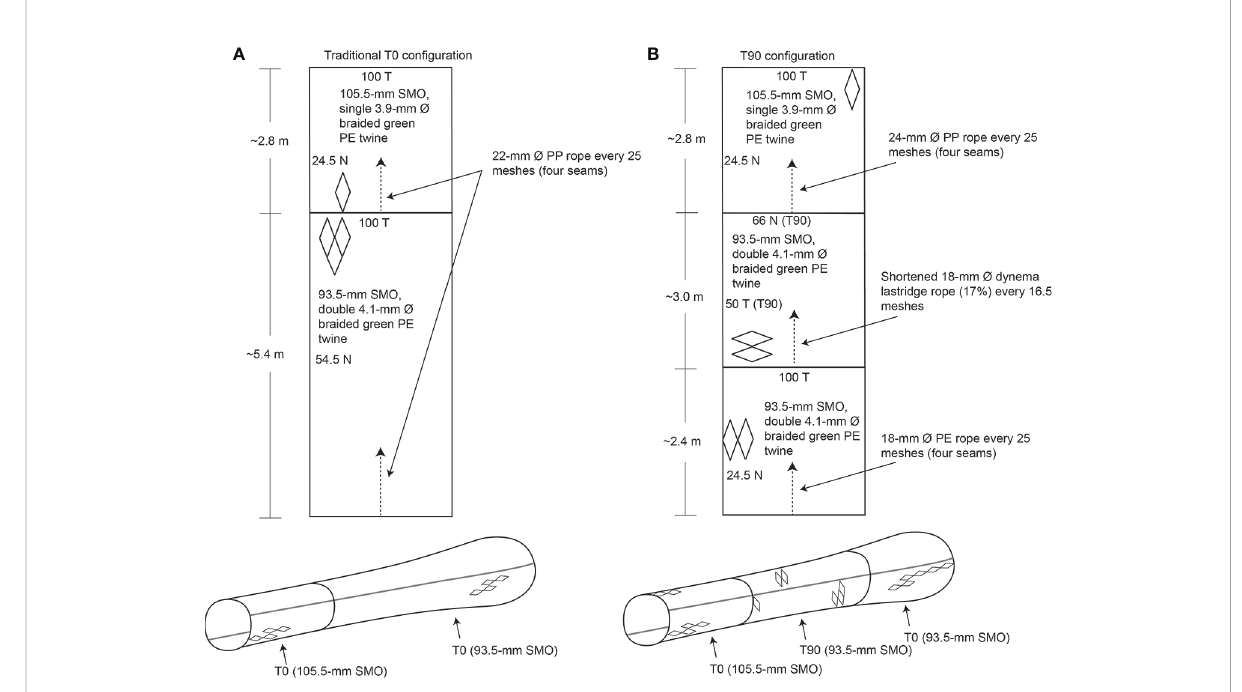
FIGURE 1 Schematic diagram of the (A) traditional T0 and (B) new T90 codends. Ø, diameter; N, normal direction; T, transverse direction; SMO, stretched mesh opening; PE, polyethylene; PP,